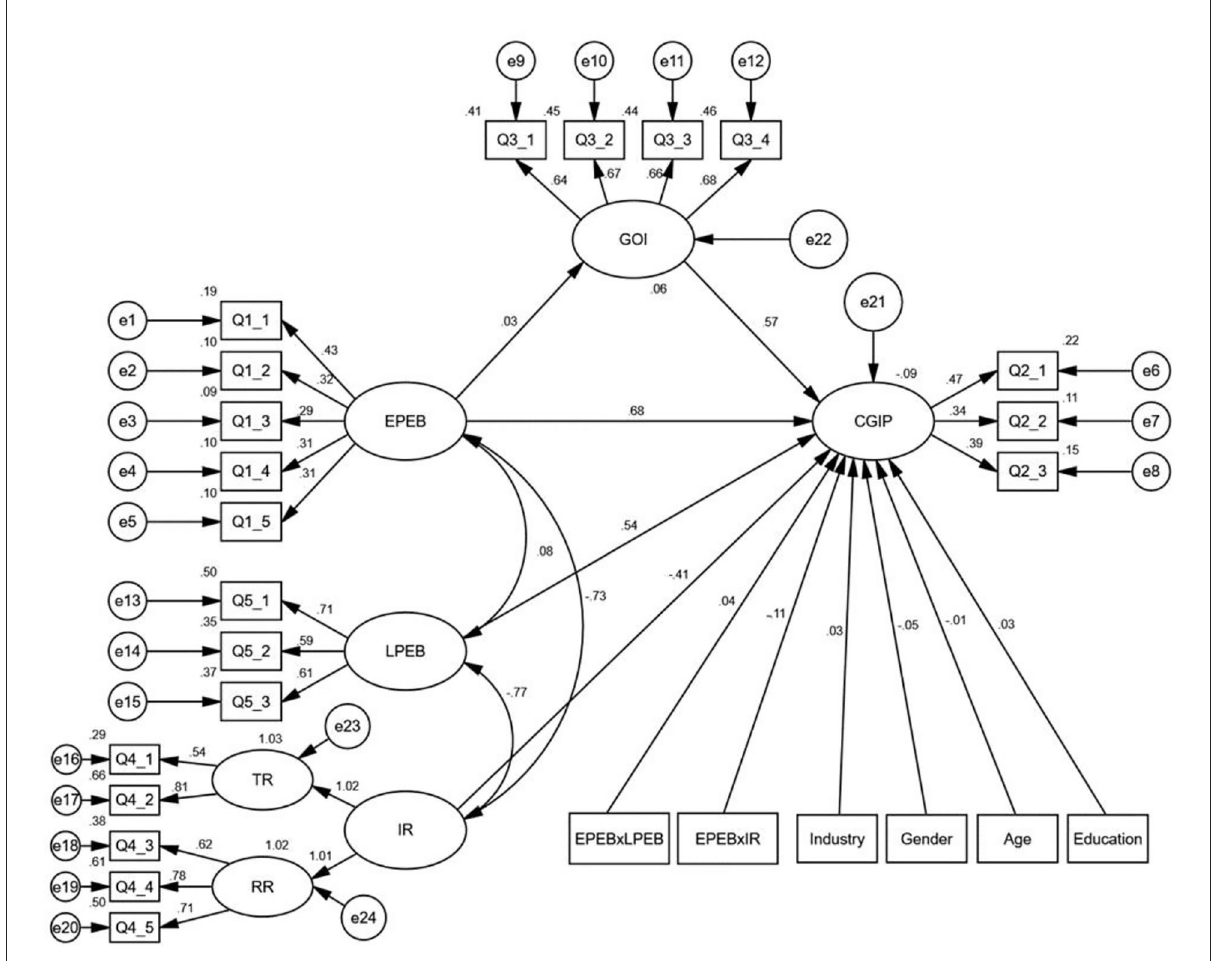
FIGURE2 Path of structural equation